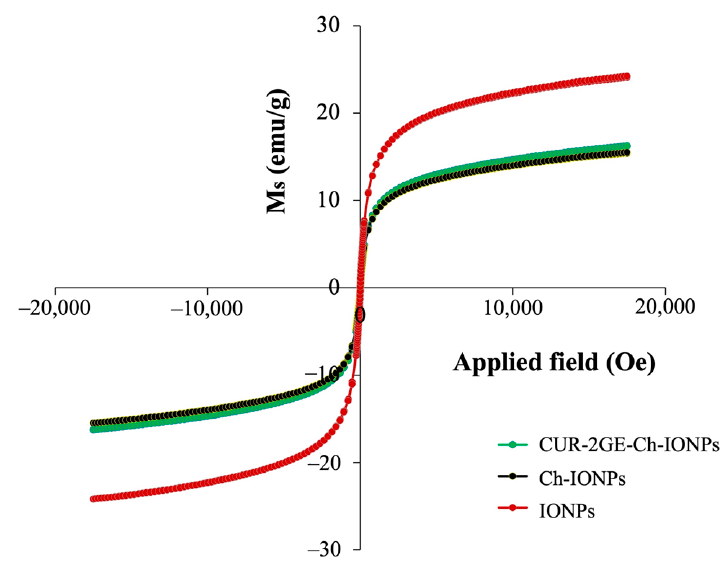
Figure 8. Magnetization behavior of the samples at room temperature.